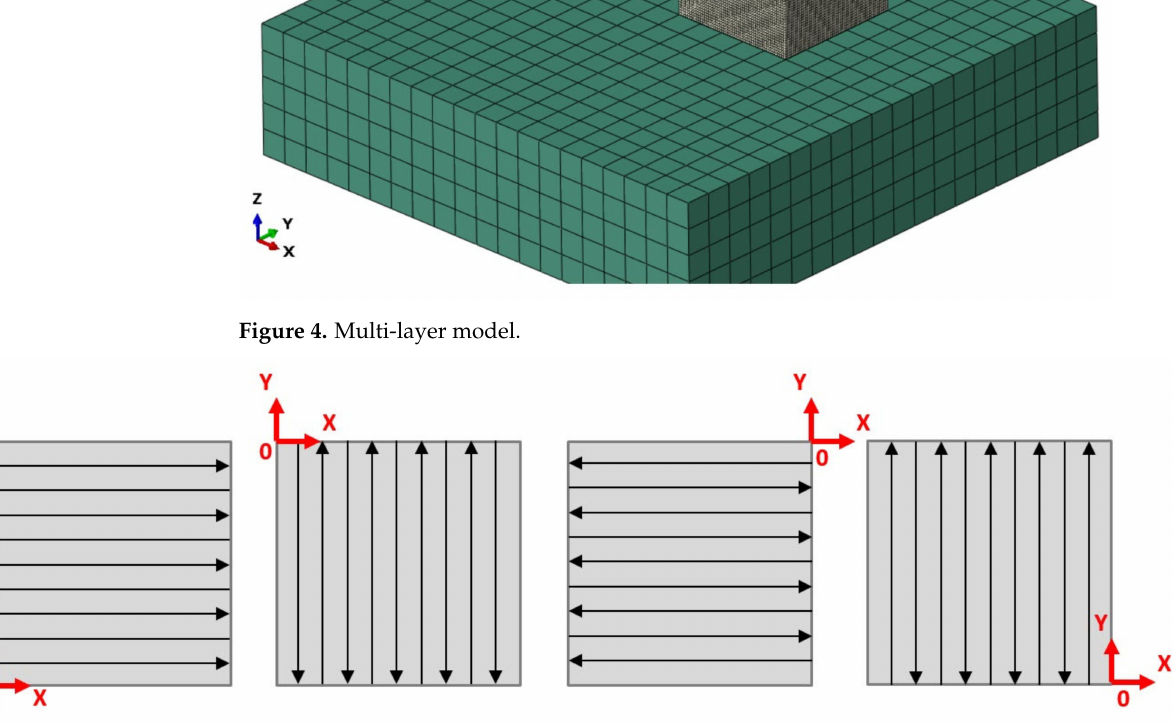
Figure 5. Alternating 0 ◦ –90 ◦ scan